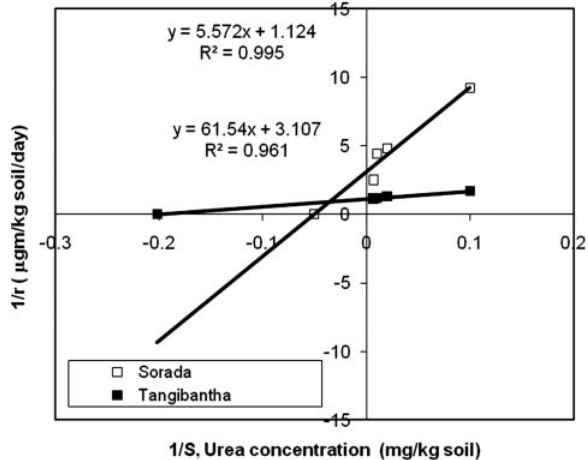
Fig. 3. Michaelis-Menten fitting curve of nitrification and denitrification routes with respect to urea addition (Condi- tions: Temperature (cid:3) 37 8 C, WFPS (cid:3)